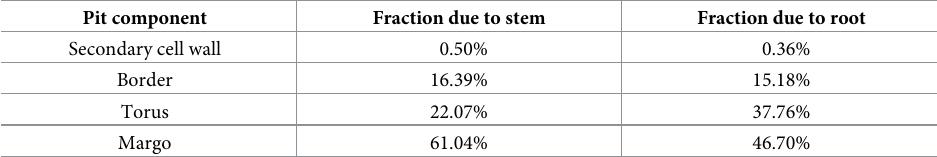
Table 5. Fraction of resistance to different components of TPS in the stems and